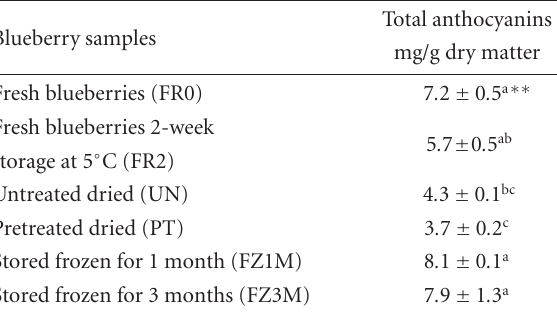
Table 1. Anthocyanin content in evaluated samples. Blueberry samples